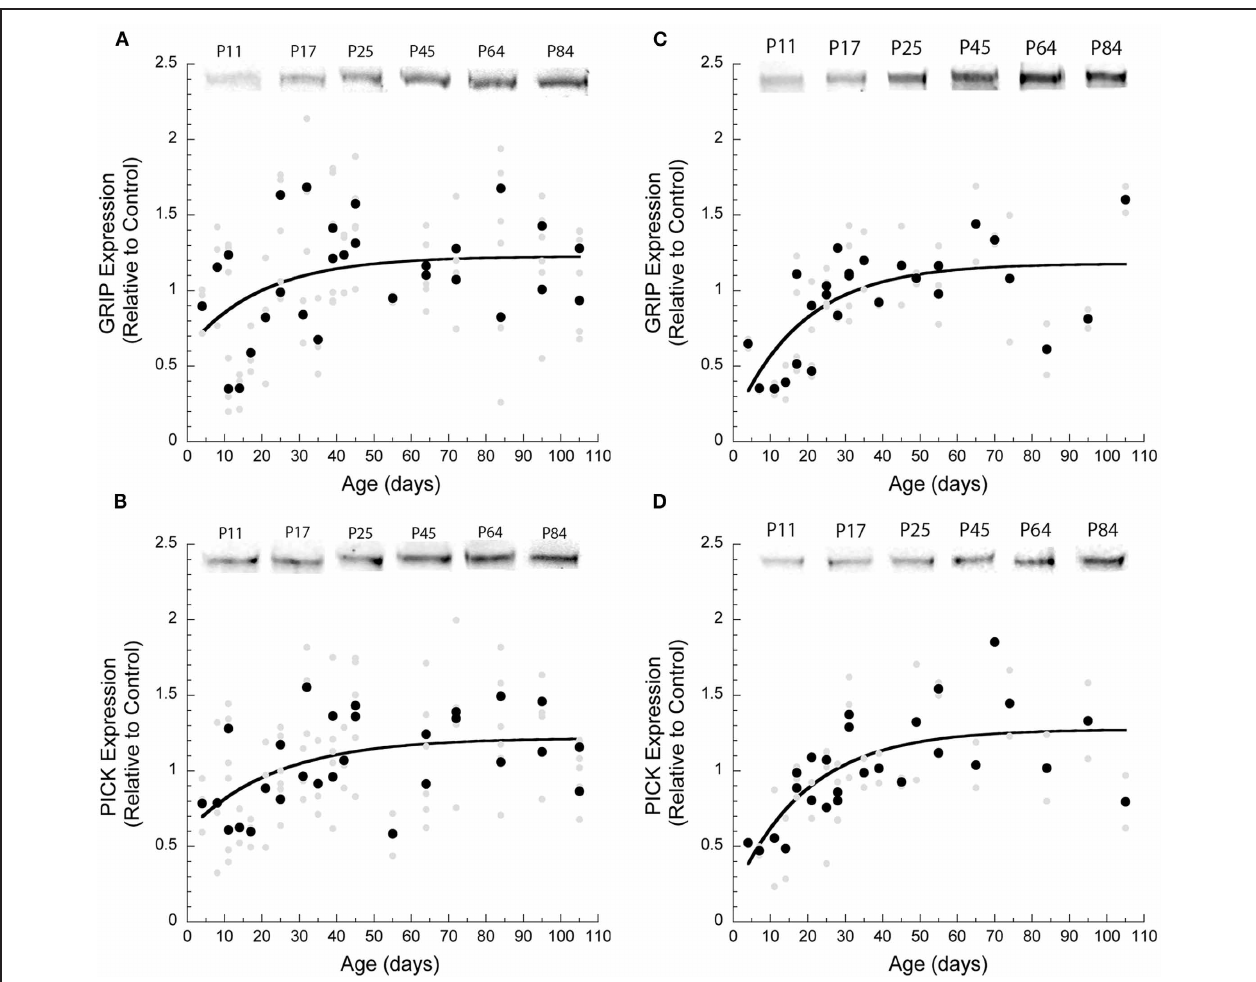
FIGURE 3 | Development of GRIP and PICK1 in visual and frontal cortex. The developmental trajectories for GRIP and PICK1 were similar in both cortical areas. Exponential decay curves were fit to all the data. (A) In visual cortex, GRIP expression levels increased by 1.7 times and reached adult levels by P60 (3 τ , R 2 = 0 . 33, p = 0.002). (B) PICK1 expression levels